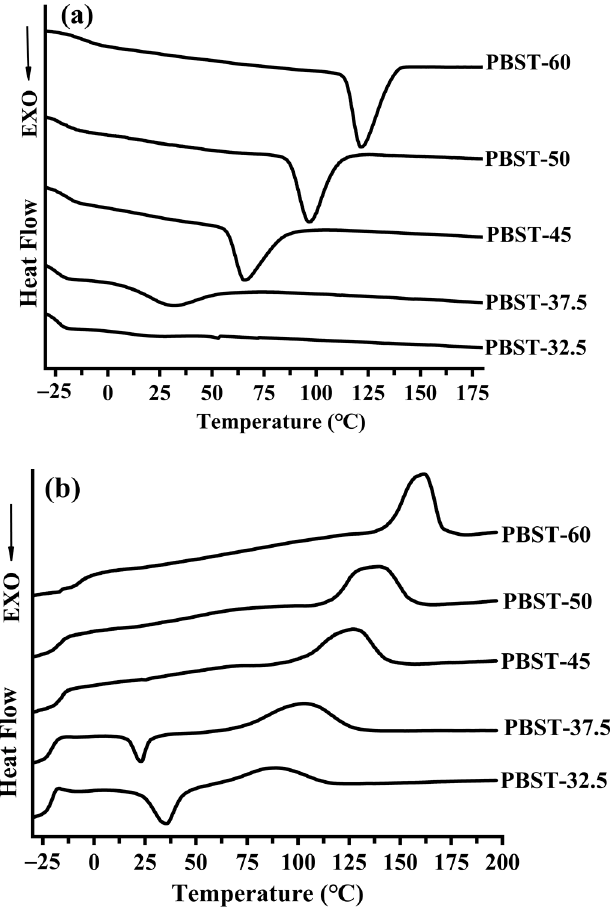
Figure 2. The heating curve of PBST copolymers with different BT contents: ( a ) primary cooling of PBST copolymers; ( b ) secondary heating of PBST copolymers. Table 3. Crystallinity of PBT in PBST copolymers with different BT contents.